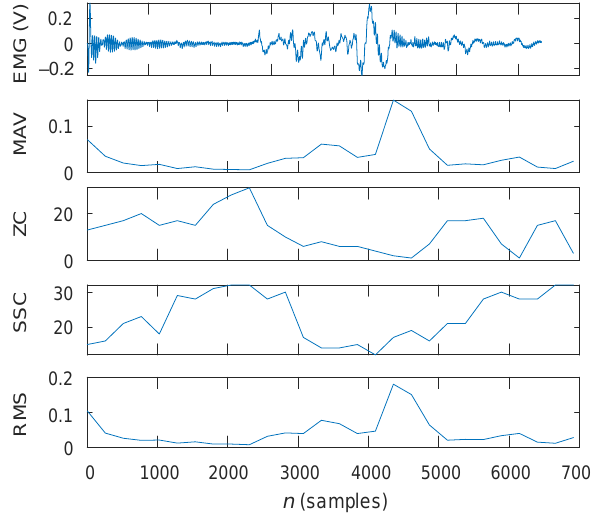
Figure 12. The lower-limb electromyogram (EMG) of a walking segment with the corresponding extracted features.